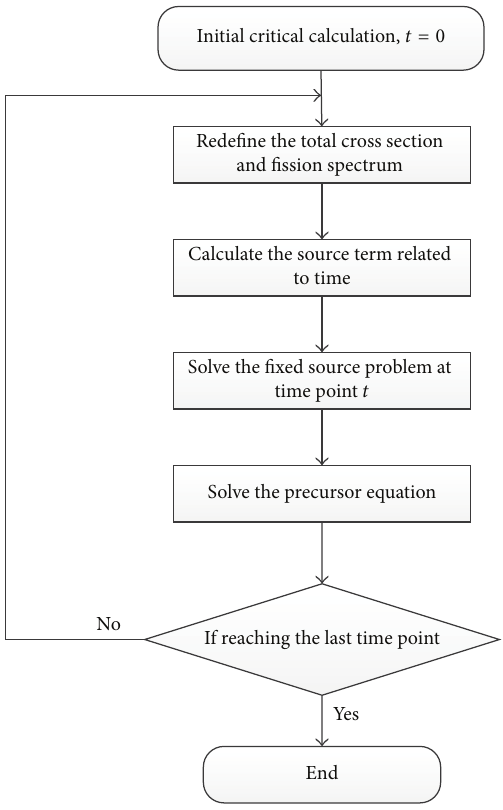
Figure 1: Calculation flow of the transient code.